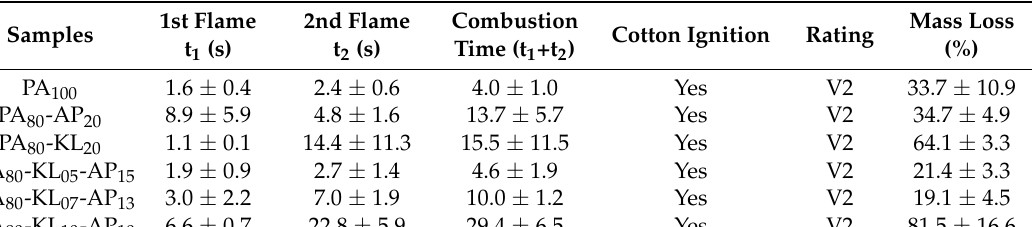
Table 4. UL94 vertical flame spread test data for PA and its blends.